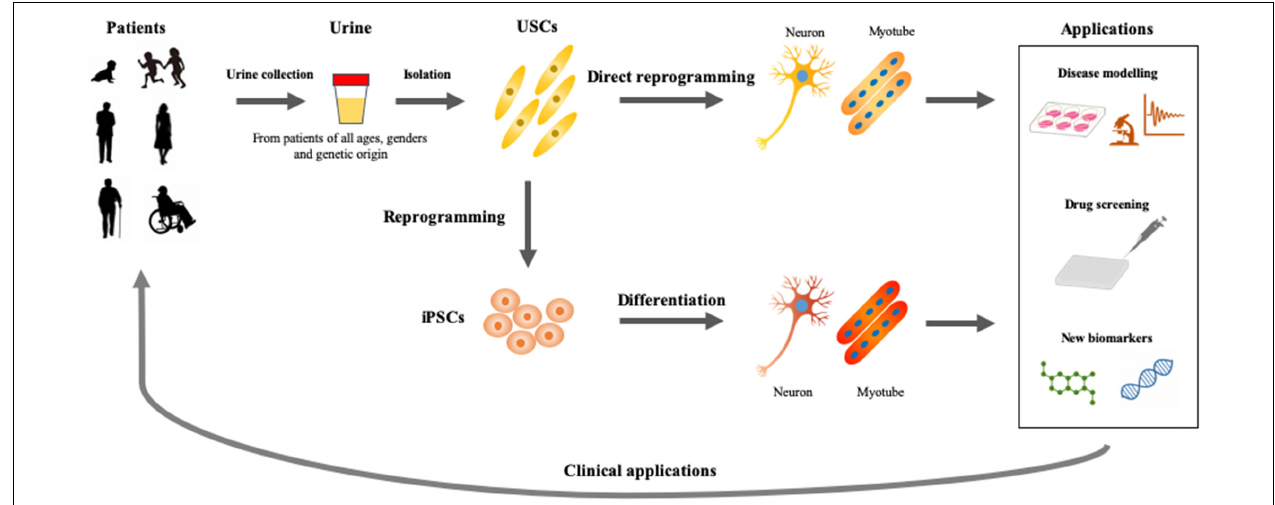
FIGURE 2 | Applications of USCs as cellular models of human diseases. Urine represents an ideal material, which could be obtained from patients of all ages and genders by non-invasive and straightforward procedures. USCs- and induced pluripotent stem cells (iPSCs)-based disease modelings would be useful for basic and applied research, which accelerate the development of personalized